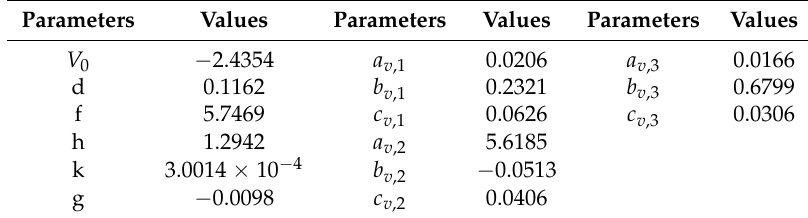
Table A3. Parameter values for the OCV–SOC function in Equation (7).